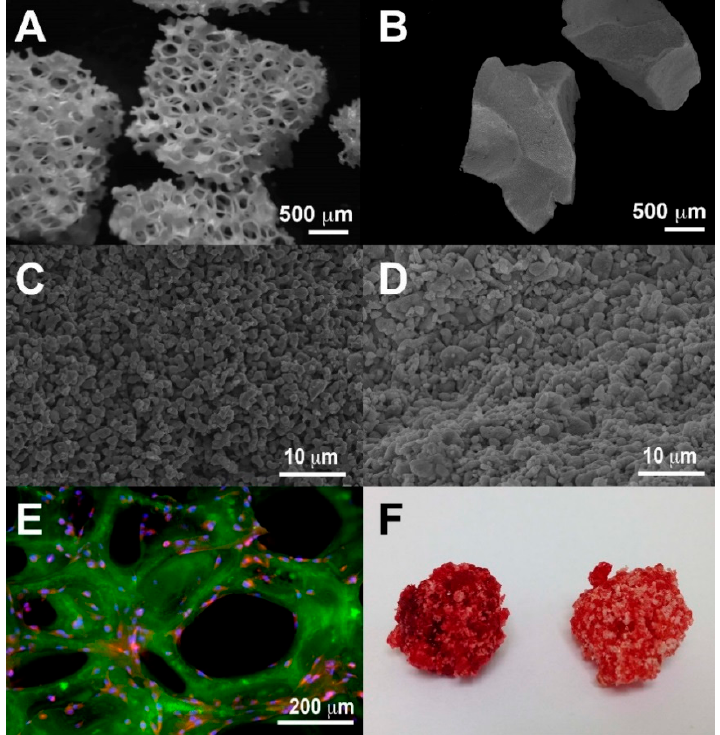
Figure 1. Porous hydroxyapatite (HA) granules ( A ) present significantly greater surface area per volume than traditional, non-porous microparticles ( B ); while the surface topography based on the 500–800 nm size of pre-sintered HA particles is similar for the porous ( C ) and non-porous ( D ) granules. ( E ) Mesenchymal cells proliferate throughout the porous HA scaffold in vitro observed by staining for nuclei (blue, DAPI) and fibrillar actin (red, rhodamine phalloidin). ( F ) The porous ( left ) and non-porous ( right ) HA graft materials form a moldable putty when hydrated with bone marrow aspirate.